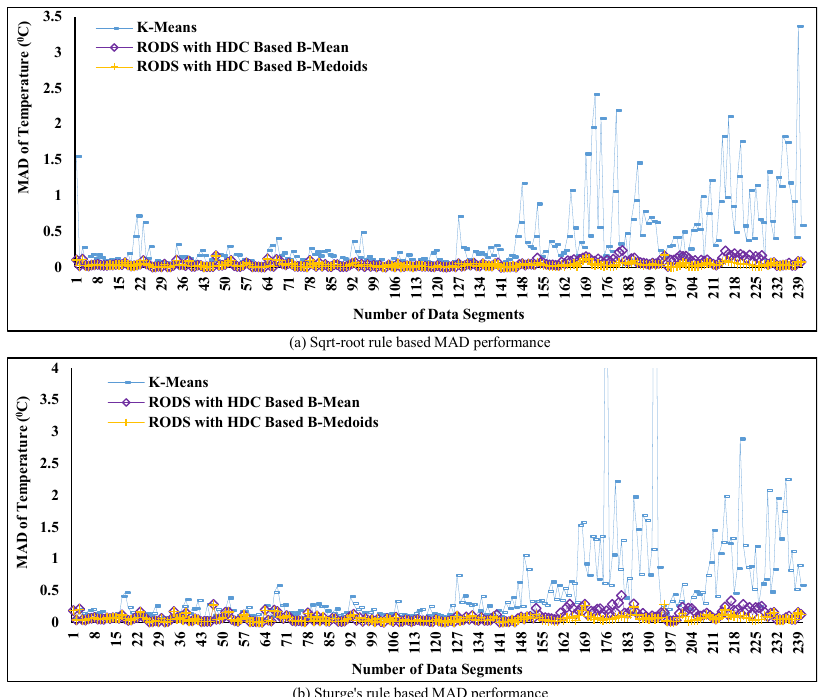
Figure 14. Performance comparison of proposed RODS with HDC-based B-means and B-medoids with conventional K-means versus the number of data segments over time. ( a ) MAD versus square-root rule (K = 11); ( b ) MAD versus Sturge’s rule (K =